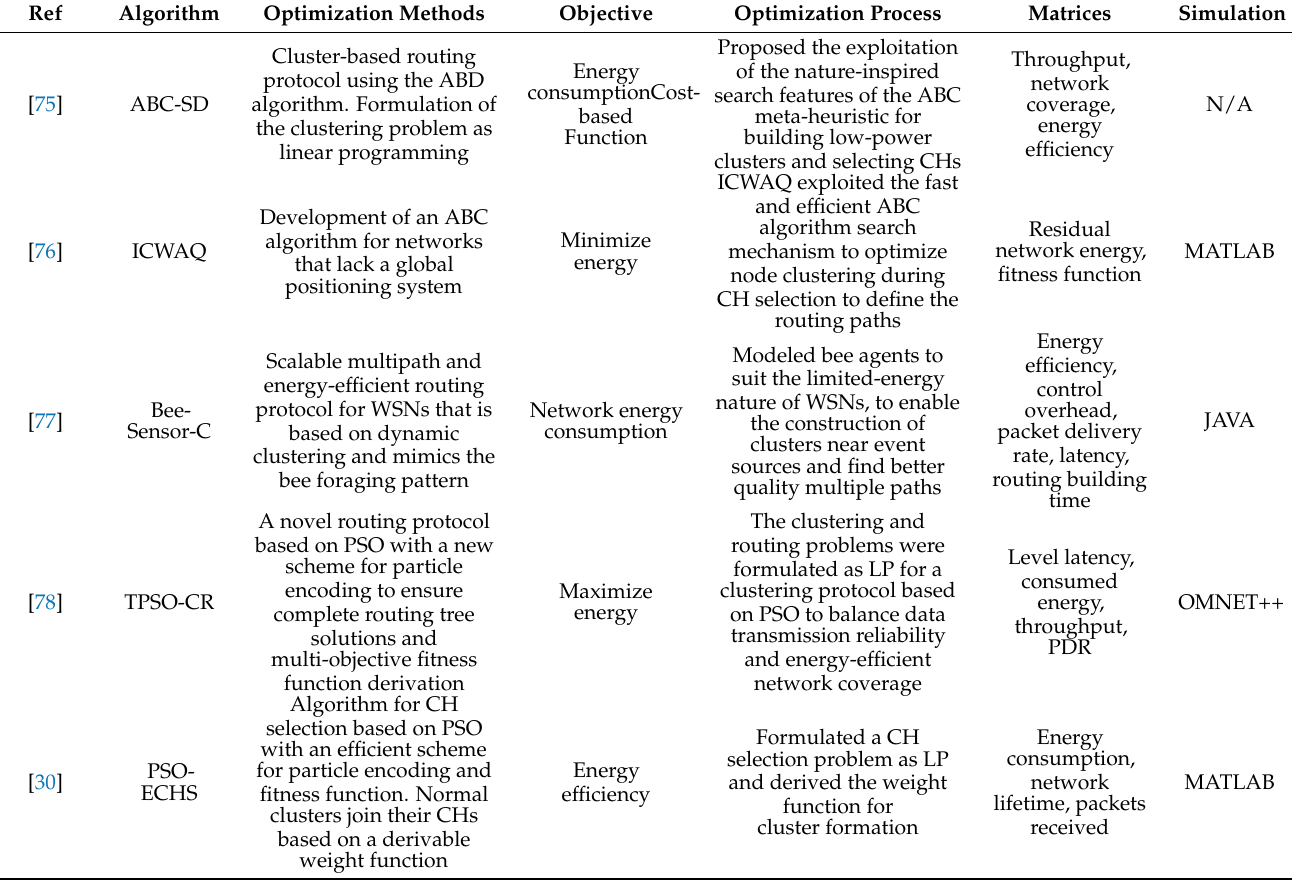
Table 4. Comparison of studies involving swarm intelligence.